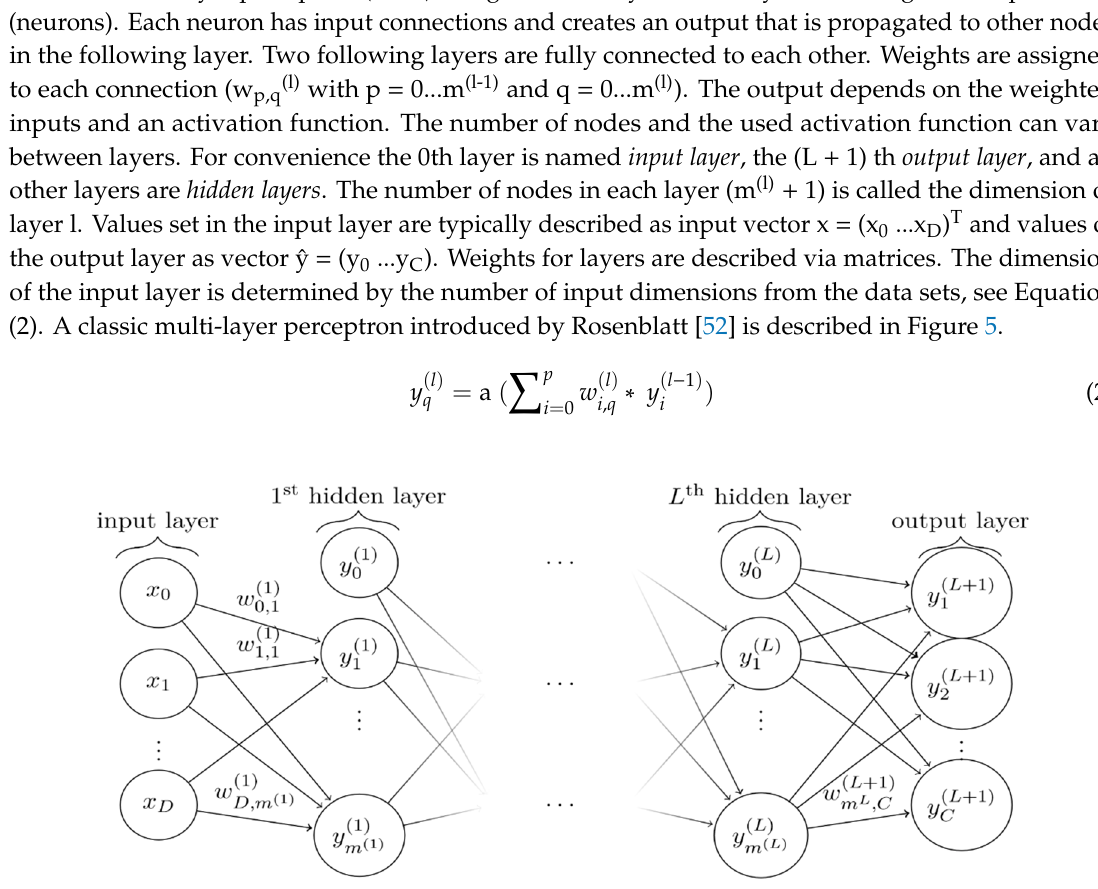
Figure 5. Multi-layer perception (MLP) with L hidden layers.